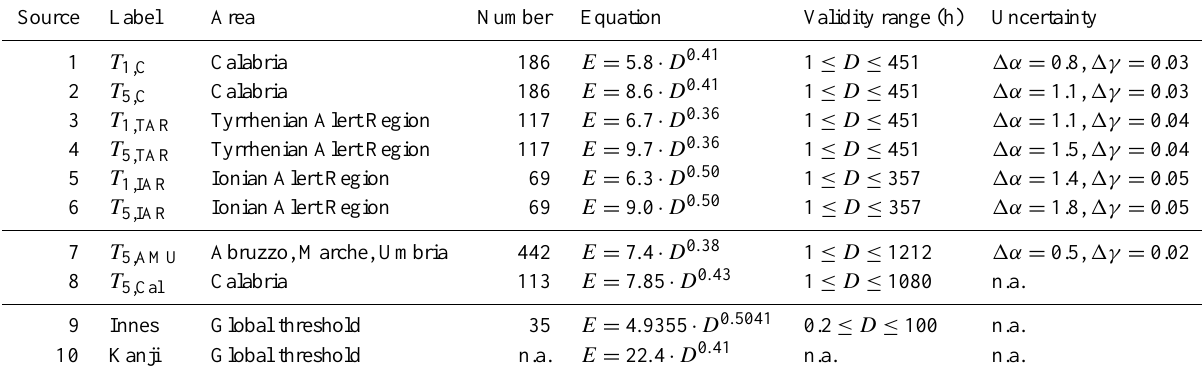
Table 2. Rainfall ED thresholds for shallow landslides in Calabria, in other areas in Italy, and globally. Number lists the number of rainfall events used to define the threshold. Source: 1 to 6, this work; 7, Peruccacci et al. (2012); 8, Brunetti et al. (2013); 9, Innes (1983); 10, Kanji et al.